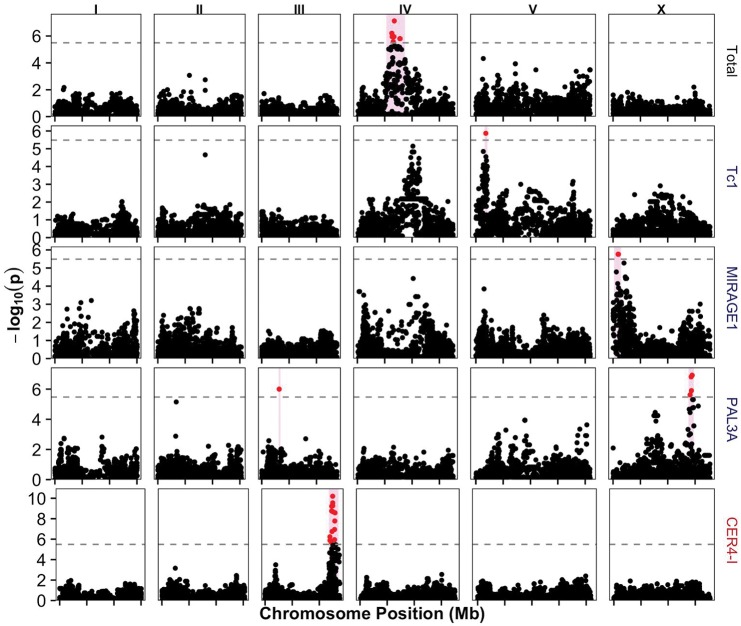
Manhattan plots for three TE count traits. These traits were filtered to retain QTL located more than 100 markers from positions with a high density of transposons and had good phenotypic splits. Total depicts the total number of insertion sites of any TE class. The mappings for Tc1 and CER4-I represent the transposon copy numbers of active reference sites. MIRAGE1 and PAL5A are the counts of insertion sites. The x-axis is the genomic position in megabase pairs (Mb) with the ticks marking every 5 Mb. The y-axis is statistical significance (−log10(P)). The significance threshold is indicated by the dotted gray line. SNVs that are above this threshold are shown in red, and SNVs that are below the threshold or do not pass our QTL filters (see Methods section) are shown in black. The genomic region containing 100 markers on either side of the peak marker are represented by the pink boxes.